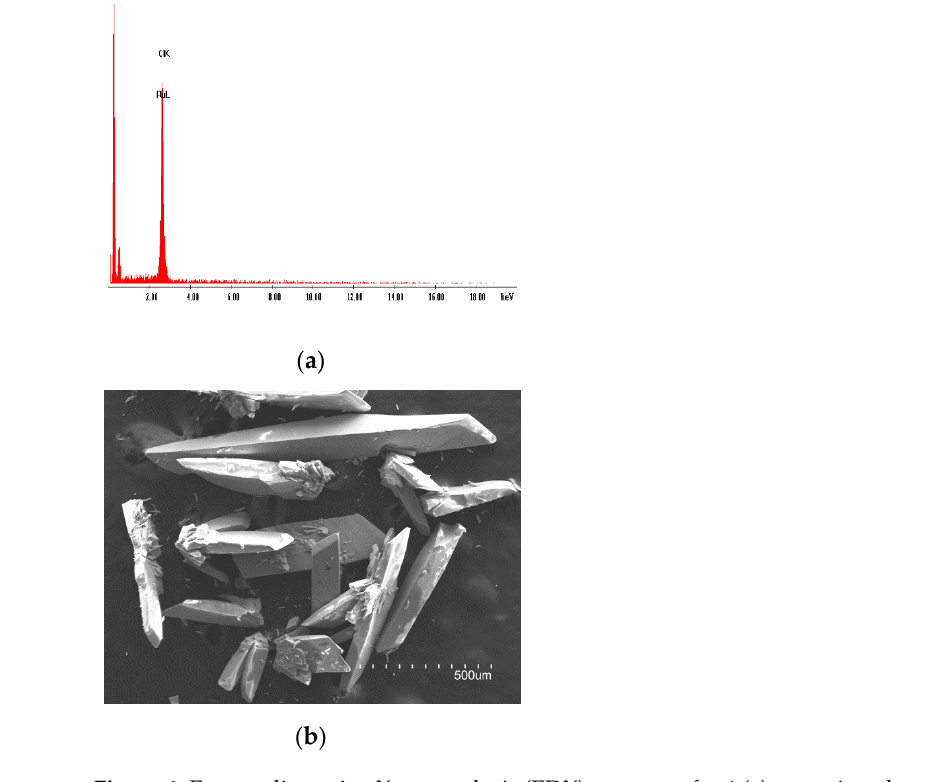
Figure 6. Energy dispersive X-ray analysis (EDX) spectrum for 1 ( a ); scanning electron microscopy (SEM) image of crystals of 1 ( b ).